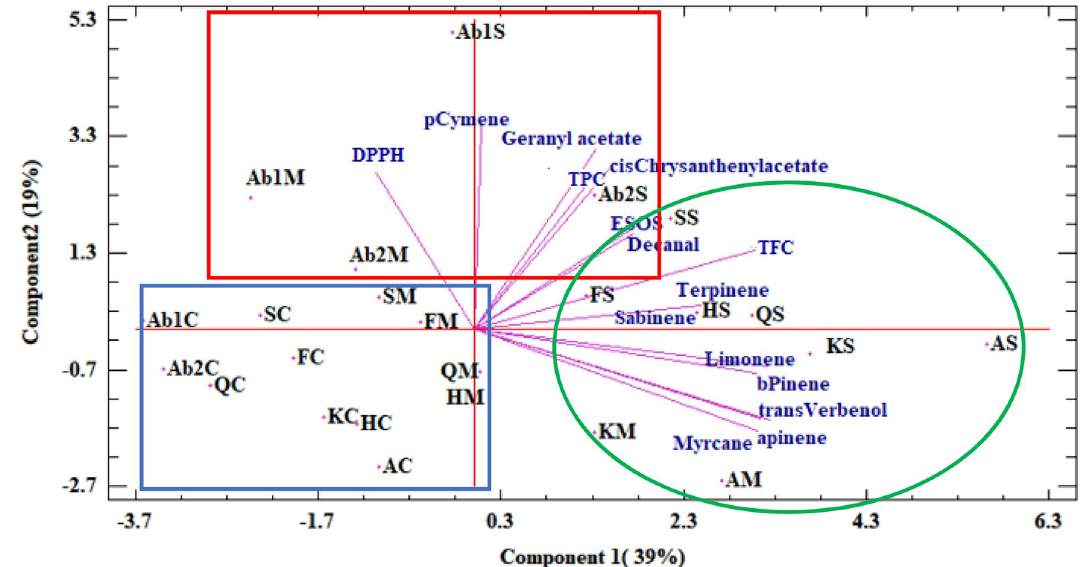
Figure 2. PCA analysis based on phytochemical characters in eight Moshgak populations in three Irrigation regimes.